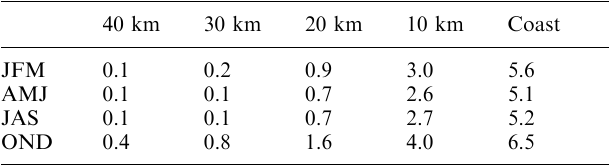
Table 3. Seasonal SN variations of the v -component of the horizontal wind (at the level of 990 hPa), at 15:00 LT, along line CD (Fig. 1). Units are m s )